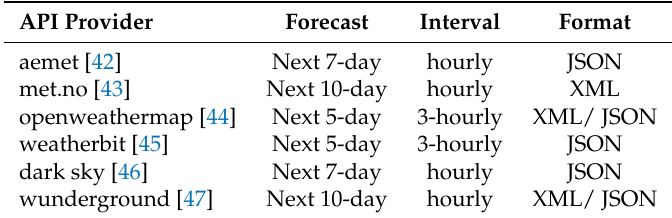
Table 1. Weather forecast